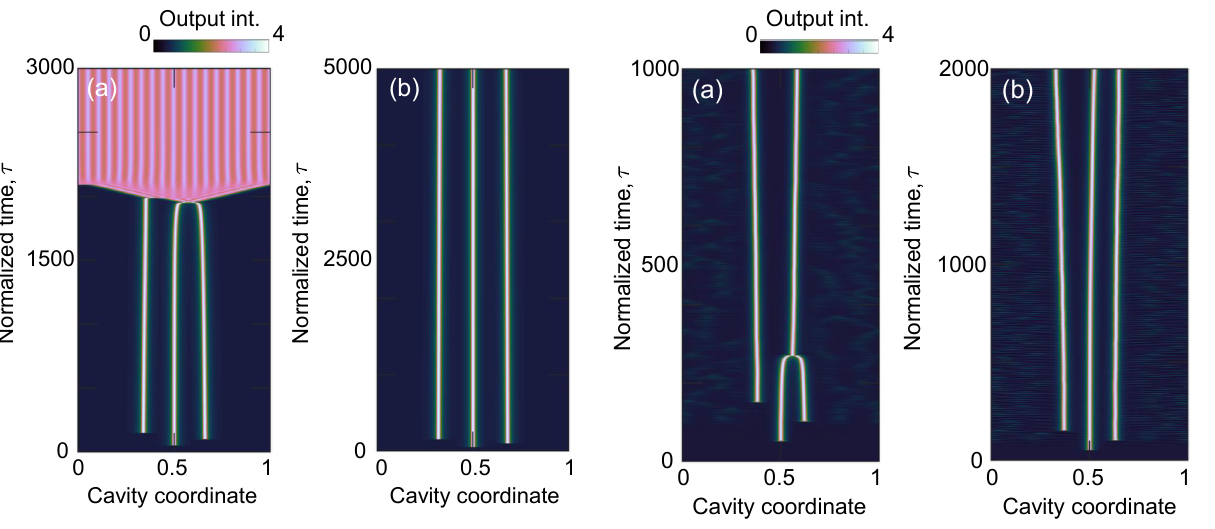
Figure 9: (a) Cavity solitons(CSs) merge into a single CS for Y = 6.6. (b)For Y = 6.4CSsdonotmergeat reportedminimumdistances, but they push/pull each other modifying their